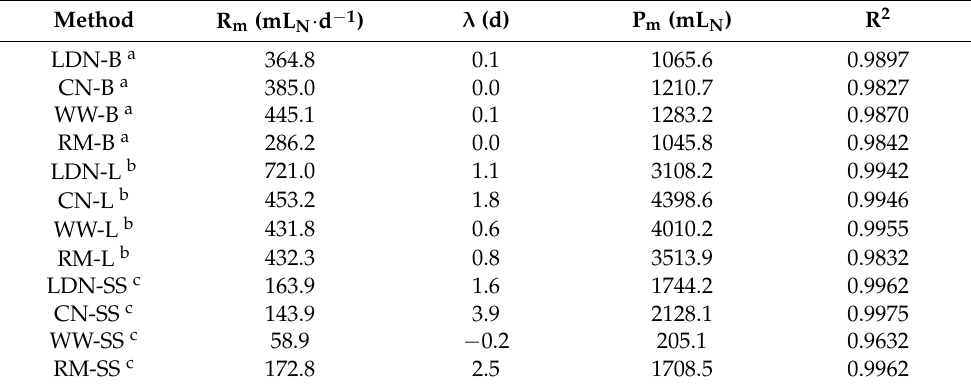
Table 2. Kinetic parameters of biomethane production with the modified Gompertz